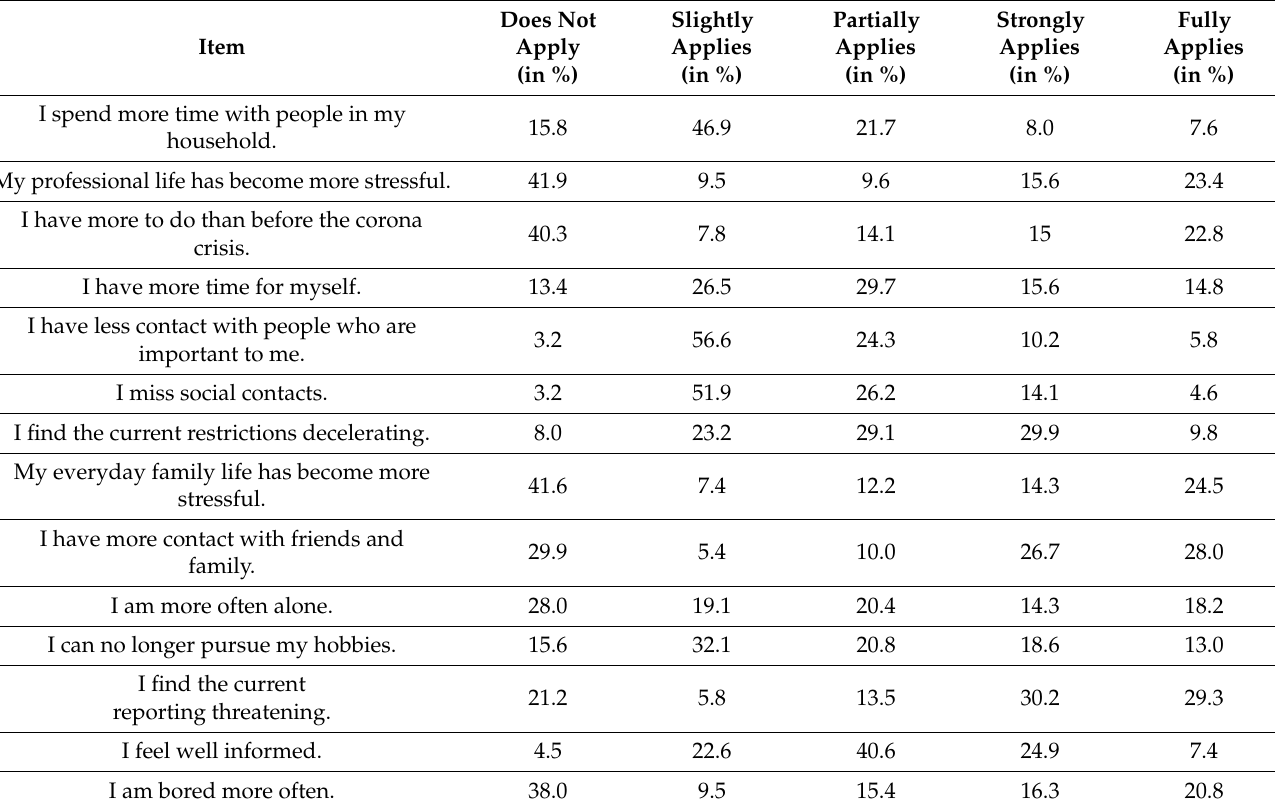
Table 4. Reported changes in everyday